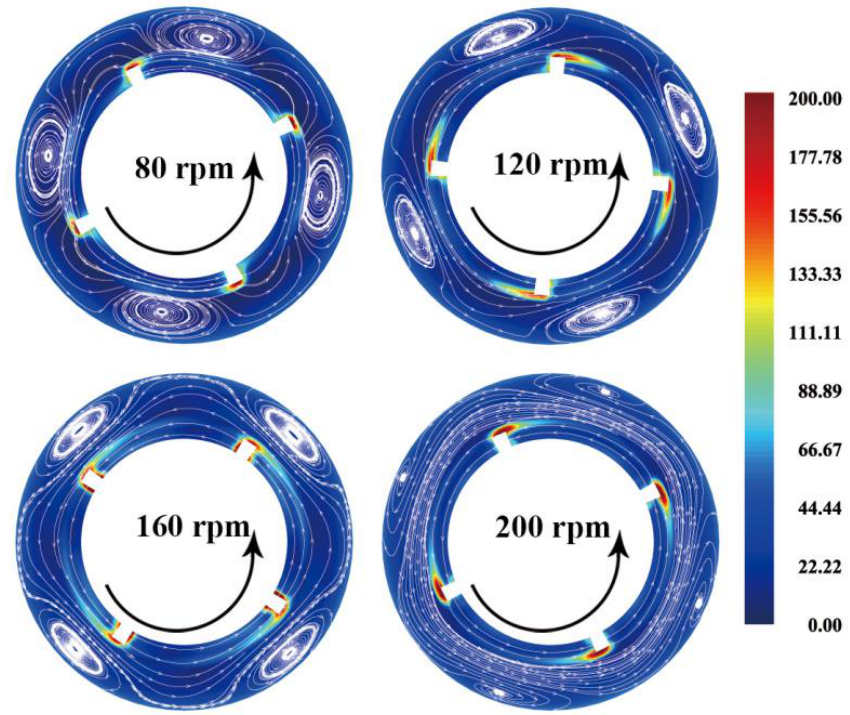
Figure 6. Vorticity and streamline distribution of the hole cleaning device ( α = 0 ◦ ) under different rotational speeds.